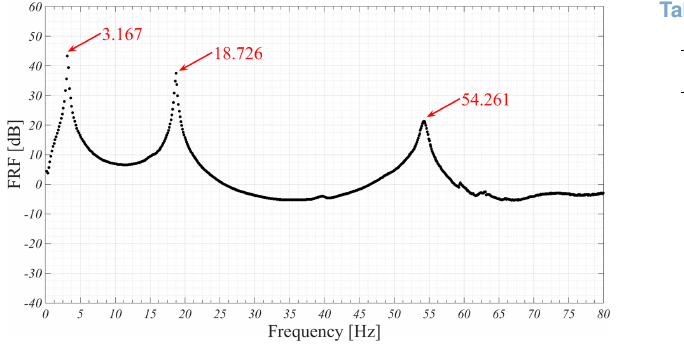
Figure 4. Frequency response function of the tower.